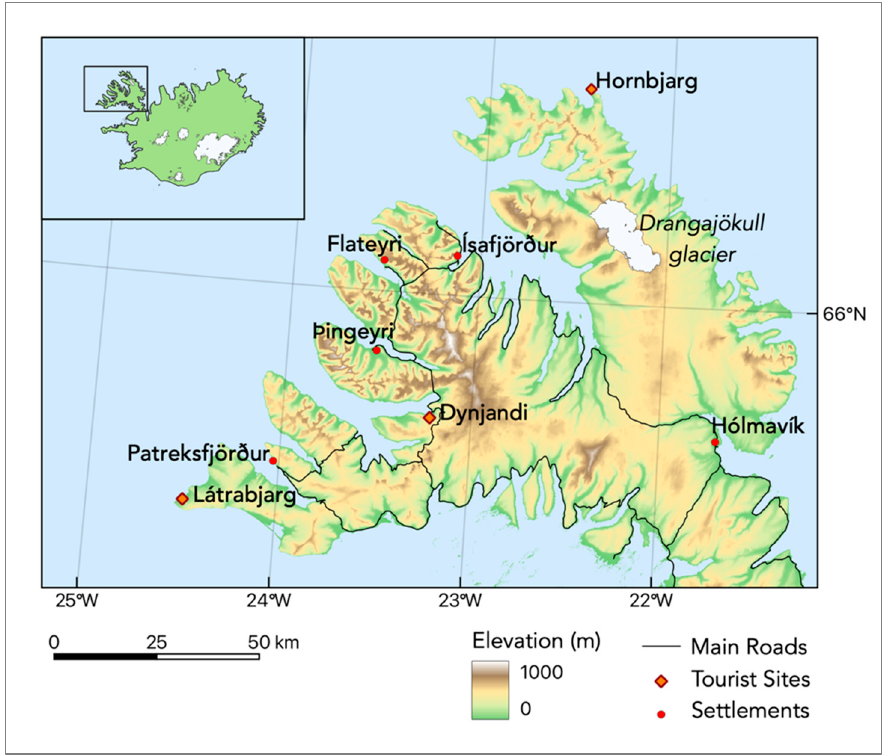
Figure 1. The location of the Westfjords region in Iceland (data source: IS50v geodatabase, obtained from the Natural Land Survey of Iceland).